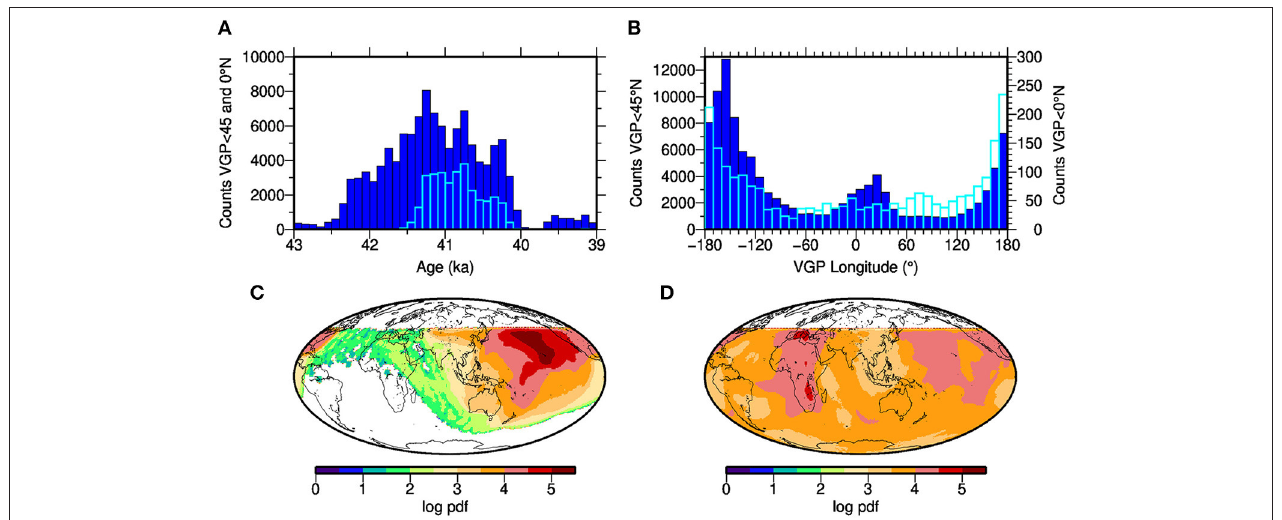
FIGURE 8 | VGP statistics during the Laschamp excursion from model C (LSMOD.2), determined from an equal area grid defined by 5 ◦ latitude by 5 ◦ longitude at the equator. (A) Temporal distribution of all VGPs ≤ 45 ◦ N (blue) and ≤ 0 ◦ N (cyan) between 43 and 39 ka in 100 yr bins. (B) Distribution of all VGPs ≤ 45 ◦ N (blue, left ordinate) and VGPs crossing the equator (cyan, right ordinate) between 43 and 39 ka by longitude in 10 ◦ bins. (C) Global density distribution of all VGPs ≤ 45 ◦ N from 42.2 to 41.2 ka and (D) from 41.2 to 40.2 ka. The logarithms of the determined smoothed probability density functions (pdf) are shown. White areas < 45 ◦ N have zero probability density, and VGP latitudes > 45 ◦ N were not plotted (white) to avoid the strong dominance by high latitude VGPs in the density distribution even during the